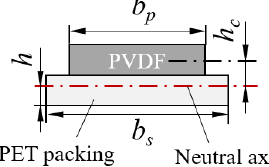
Figure 4. Cross-section of the simplified PVDF